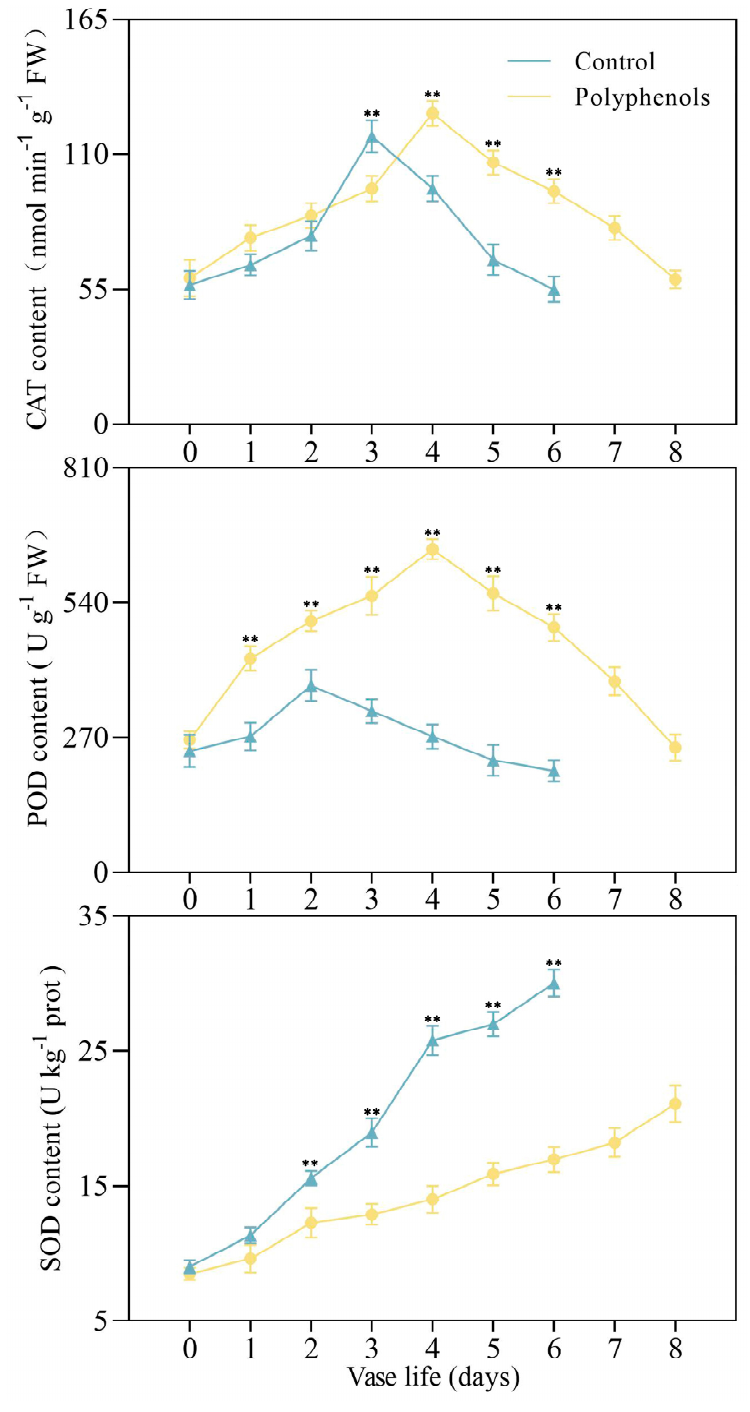
Figure 3. Effect of polyphenols on protective enzyme activity of cut herbaceous peony flowers. ** indicates highly significant difference of data, p <